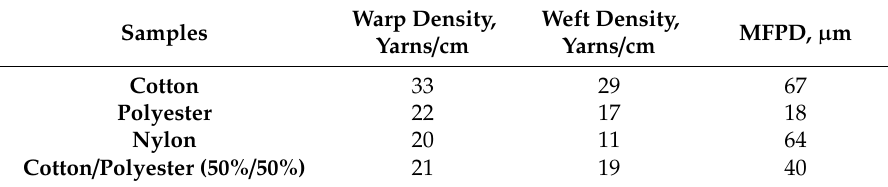
Table 2. Structural characteristics of the fabrics. MFPD, mean flow pore diameter. Warp Samples